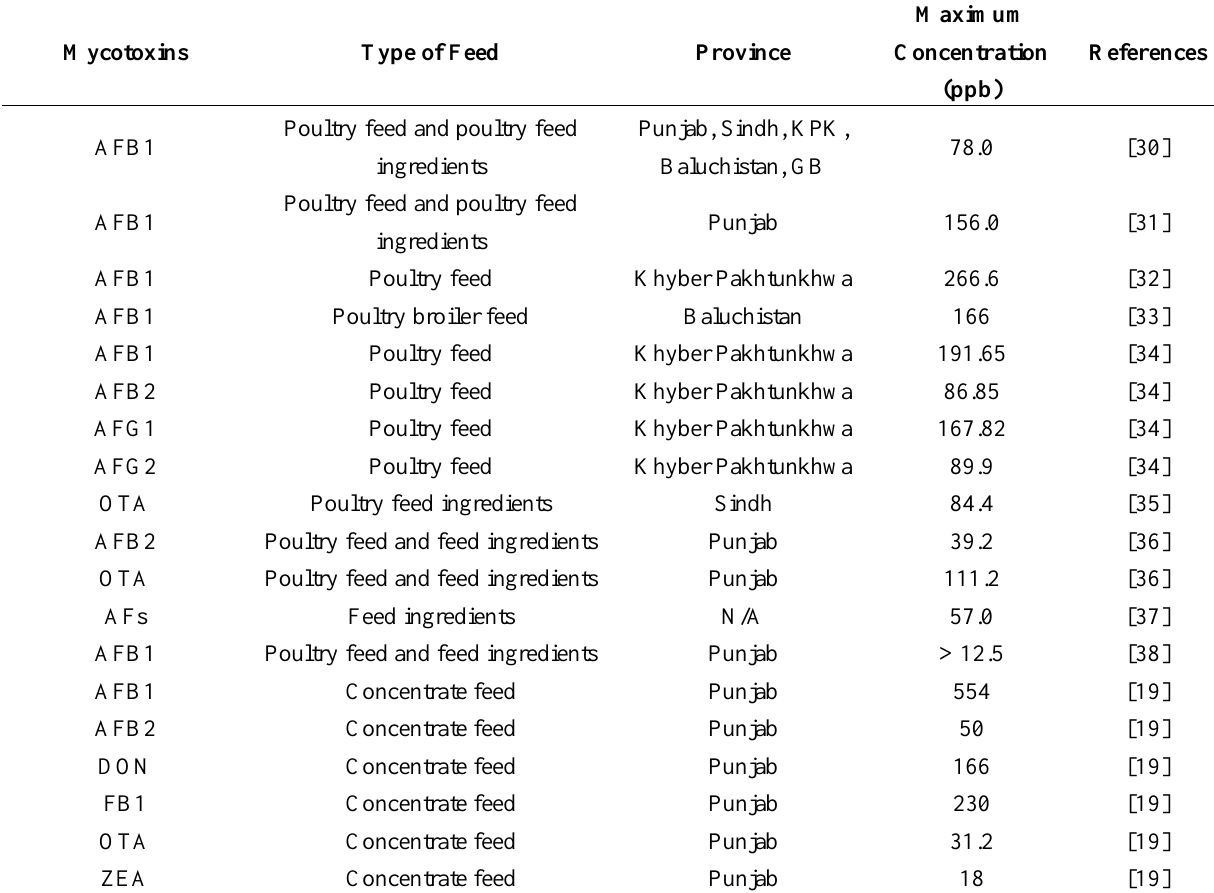
Table 1. Prevalence of various mycotoxins in animal feed in